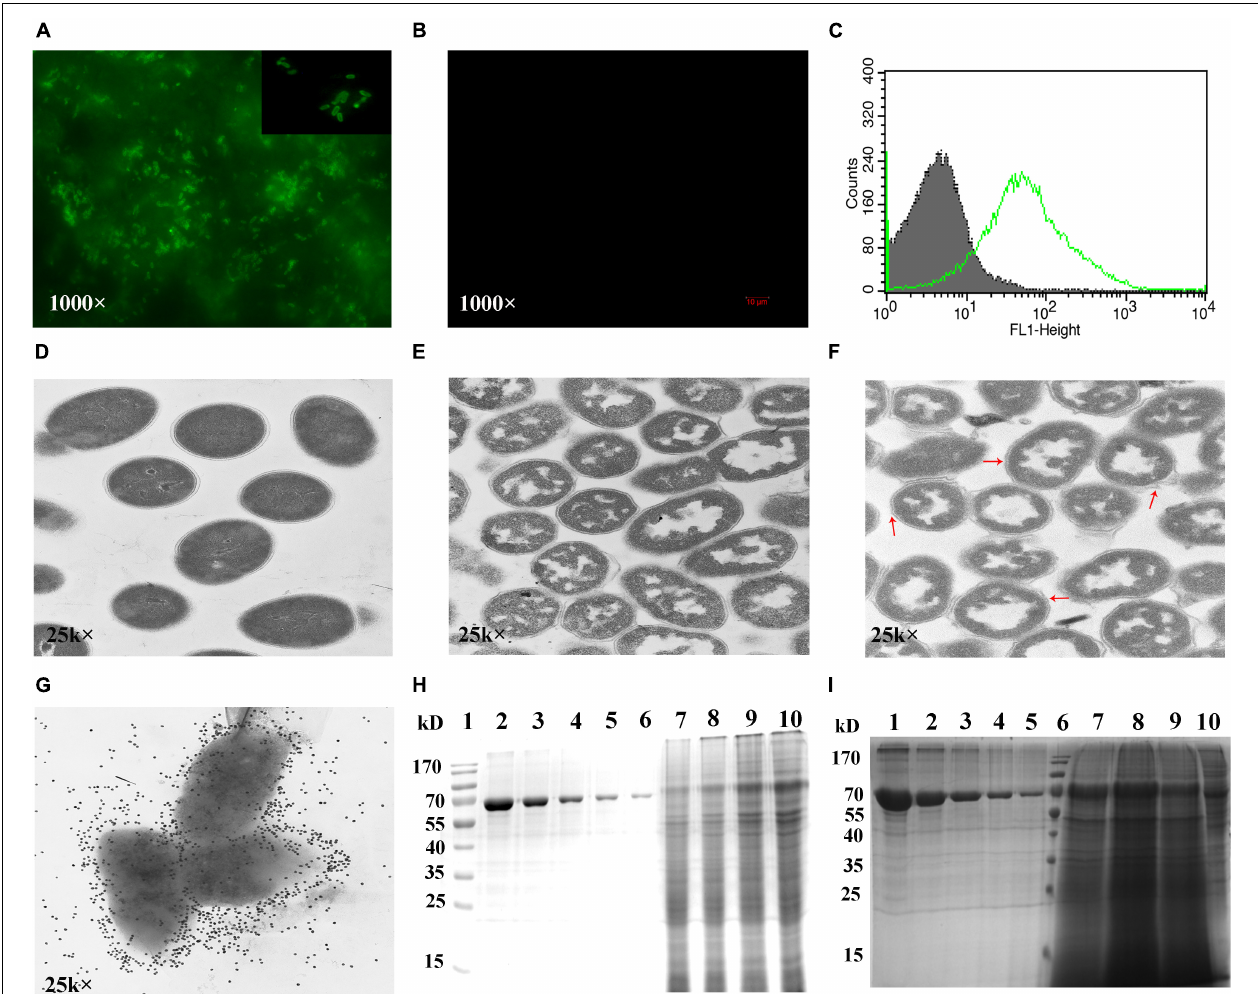
FIGURE 4 | Detection of fusion protein displayed on the surface of GEM particles. IFA experiment detection of RVFV-BLPs labeled by goat antimouse FITC (A) and no fluorescence found in GEM particles (B) . FACS histograms of RVFV-BLPs (green) and GEM particles (gray) (C) . TEM and immunogold labeling images of RVFV-BLPs, L. lactis MG1363 (D) , GEM particles (E) and RVFV-BLPs (F) . Fusion protein on the surface of GEM particles detected by immunogold labeling (G) . The maximum binding capacity of the fusion protein displayed on GEM particles was determined by SDS-PAGE (H,I) . In (H) , lane 1 is protein marker, lanes 2–6 are BSA, 0.5–0.03125 mg/ml. 1U GEM particles mixed with 1 (lane 7), 2 (lane 8), 3 (lane 9), and 4 mL (lane 10). In (I) , lanes 1–5 are BSA, 0.5–0.03125 mg/ml. Lane 6 is protein marker, 1U GEM particles mixed with 6 (lane 7), 8 (lane 8), 10 (lane 9), and lane 10 is the supernatant containing RVFV Gn head-PA fusion protein.